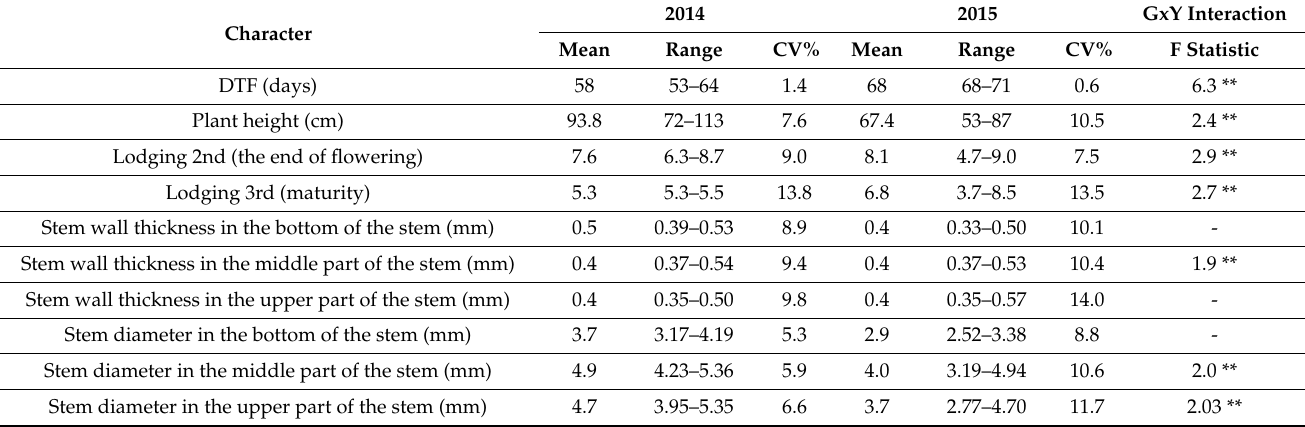
Table 2. Differentiation of pea cultivars based on DTF, plant height, lodging, stem diameter, and thickness of stem